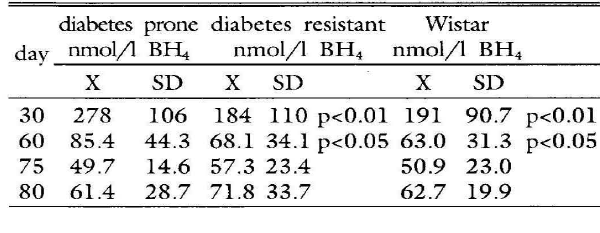
Table 1. Mean serum BH. concentration for Wistar con trol rats receiving subcutaneous BCG (n=8 ) compared to vehicle alone (n=8). BCG was administered on day 1.